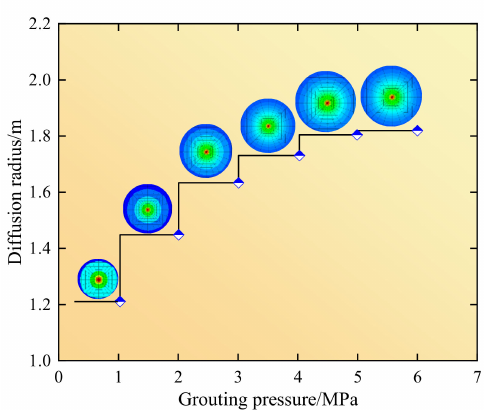
Figure 16. E ff ect of grouting pressure on di ff usion radius.